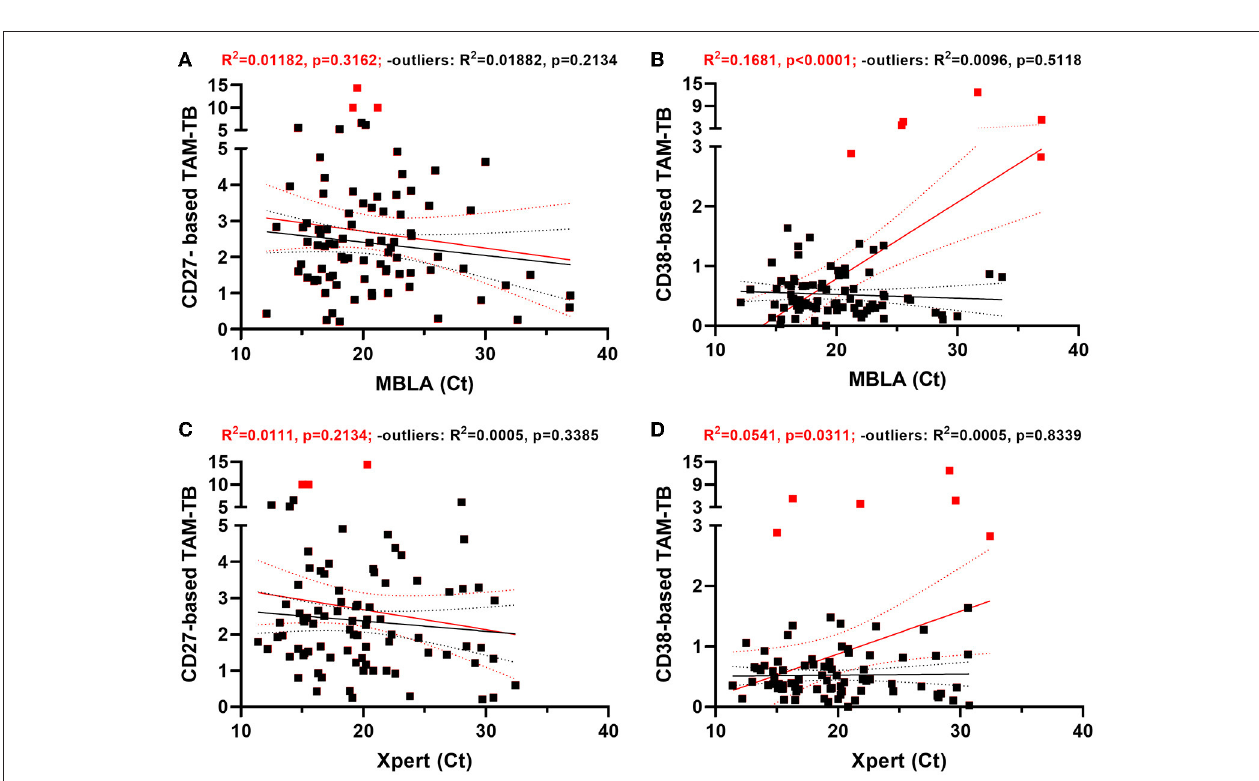
FIGURE 2 | CD38- and CD27-based TAM-TB signals are independent of sputum bacterial load proxies at time of diagnosis. (A–D) Linear regression analysis comparing the strength of the association between CD27 or CD38 biomarker expression by Mtb -specific CD4T cells (CD27- or CD38-based TAM-TB) and sputum molecular bacterial load assay (MBLA) or Xpert MTB/RIF results from, respectively, blood and sputum specimen of TB patients at time of diagnosis. Regression analysis was performed including (red lines and statistical results) or excluding (black lines and statistical results) potential outliers (red squares) identified using the ROUT